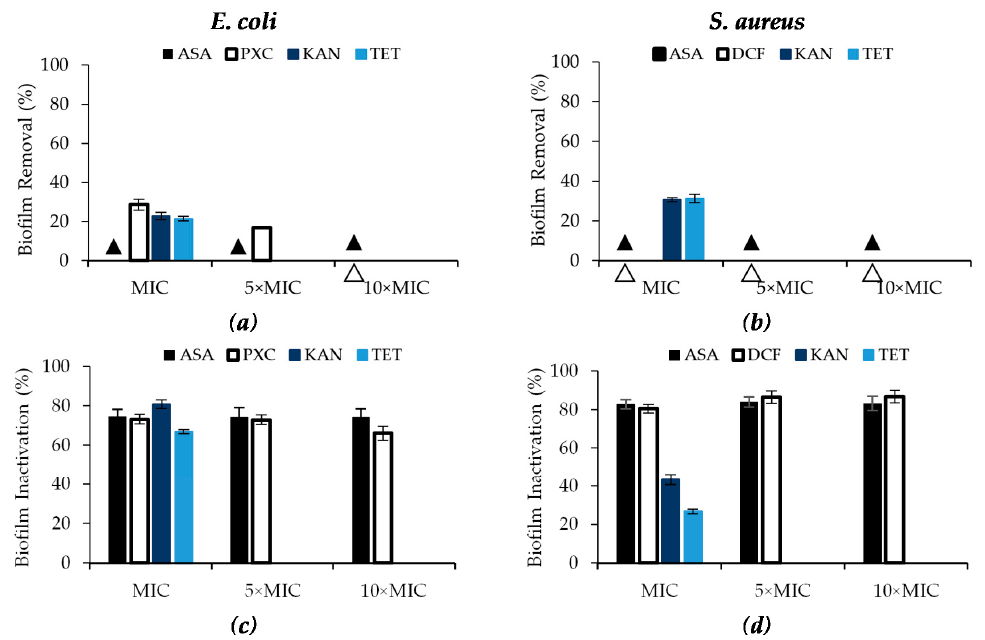
Figure 3. Effects of PXC (piroxicam), DCF (diclofenac sodium), ASA (acetylsalicylic acid), at three different concentrations (MIC, 5× MIC and 10× MIC) and KAN (kanamycin) and TET (tetracycline) at MIC (in this case, 5× MIC and 10× MIC were not tested) against E. coli and S. aureus after 24 h of exposure in terms of: ( a , b ) biomass removal (%) and ( c , d ) biofilm inactivation. ▲ / ∆ represents 0% biofilm removal. Mean values ± SD of three independent experiments are illustrated.